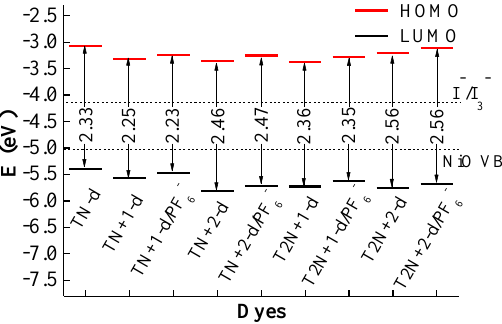
Figure 6. Comparison of the frontier molecular orbital energy levels and energy gaps of RN + / PF 6 − and